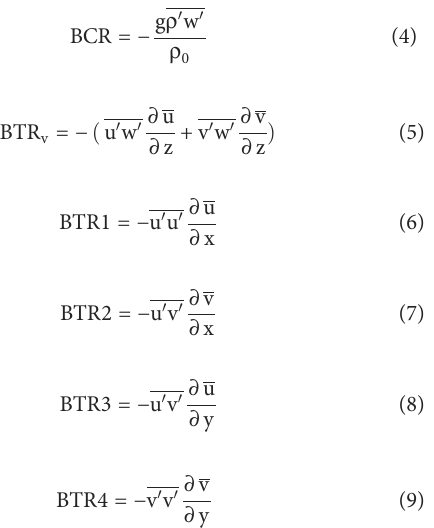
(cid:1) u and (cid:1) v are zonal and meridional components